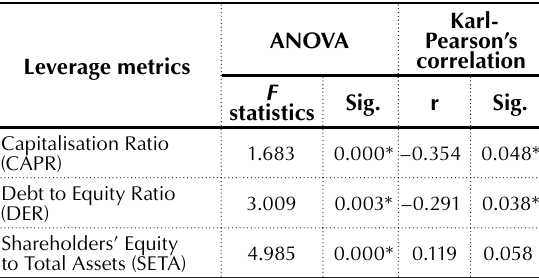
Table 4. Results of ANOVA and correlation analysis of the relationship between capital structure and dividend pay-out